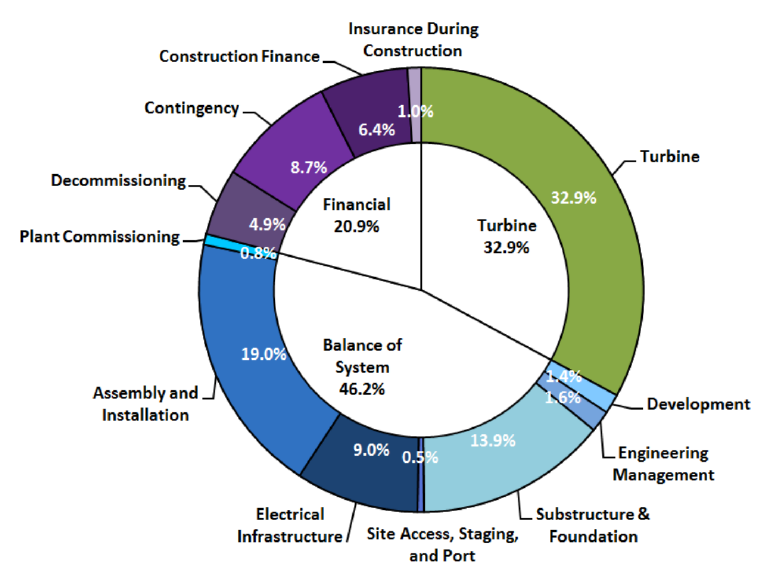
Figure 5. Capital expenditures for a fixed-bottom offshore reference wind plant project (adapted from [20], with permission from the National Renewable Energy Laboratory, https://www.nrel.gov/docs/fy18osti/70363.pdf, accessed May 15, 2020).